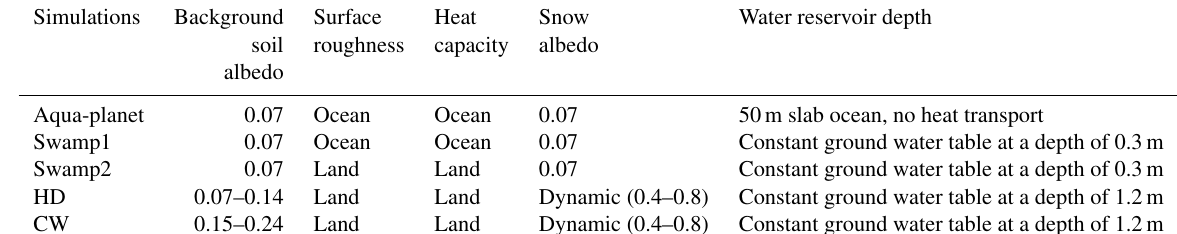
Table A1. Summary of simulations performed to illustrate the procedure by which we found bistability on our terra-planet. Simulations